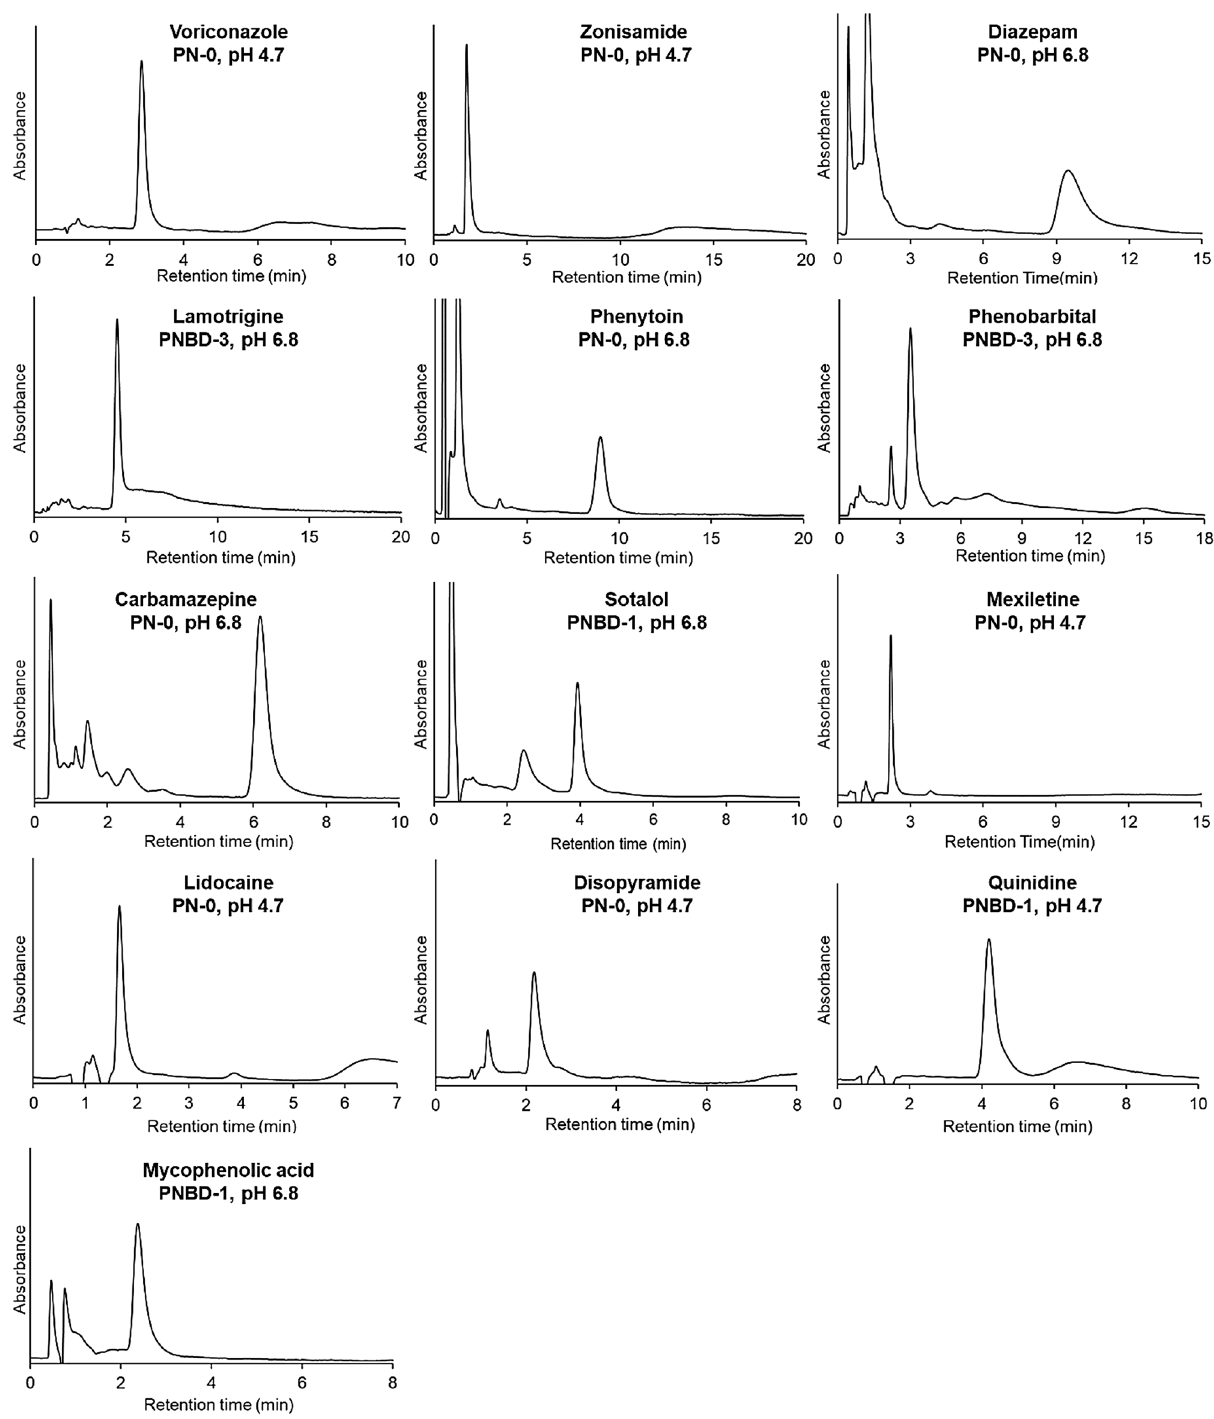
Figure 5. Chromatograms of the drugs with serum proteins obtained using the suitable columns packed with thermoresponsive cationic-copolymer-modified silica beads. Mobile phase: 10 mmol/L CH 3 COONH 4 (pH 4.7) or 10 mmol/L CH 3 COONH 4 (pH 6.8); flow rate: 1.0 mL/min. Detection wavelengths for each drug are summarized in Table